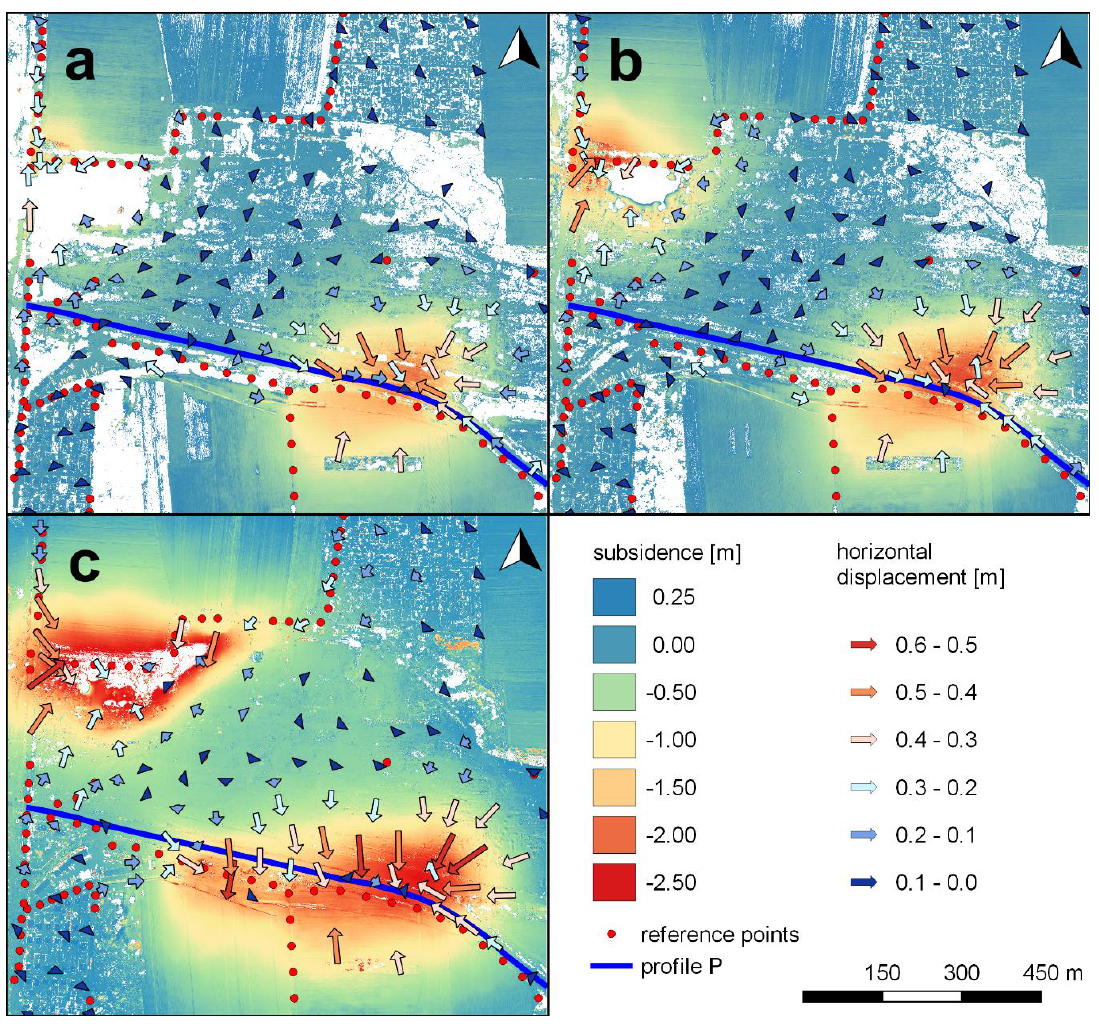
Figure 3. Displacements determined using UAV photogrammetry at the Piekary site during: ( a ) 03.2016 – 09.2016, ( b ) 03.2016 – 11.2016, and ( c ) 03.2016 – 04.2017.